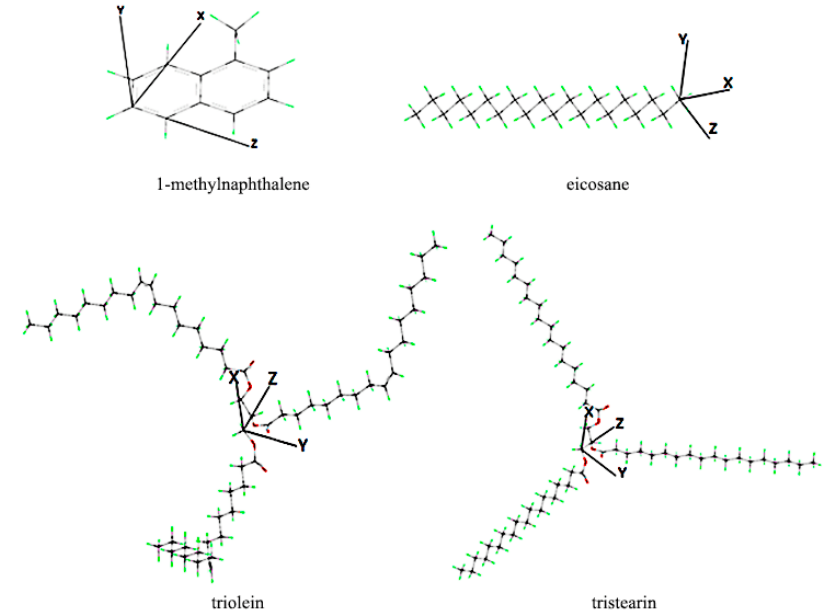
Figure 1. Models of typical molecules with Cartesian axis. Gray: C, red: O, green: H.